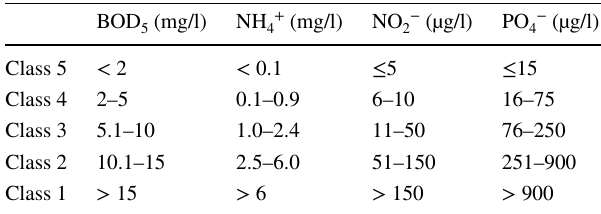
Table 10 Class limits of organic pollution index (Benkhedda et